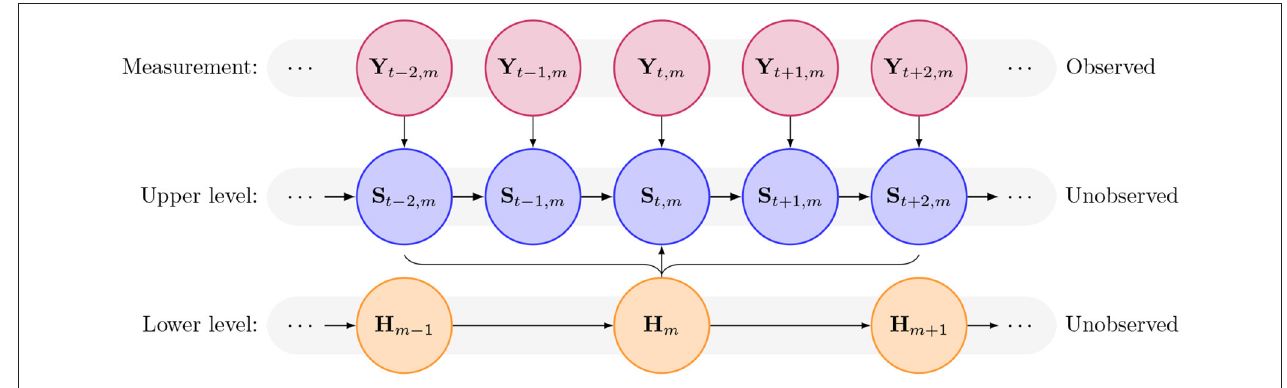
FIGURE 1 | Diagram of dependence structure in the hierarchical hidden Markov model, showing the observed measurement layer, the high-resolution upper states, and the lower-resolution lower states, the latter two of which are unobserved latent states to be